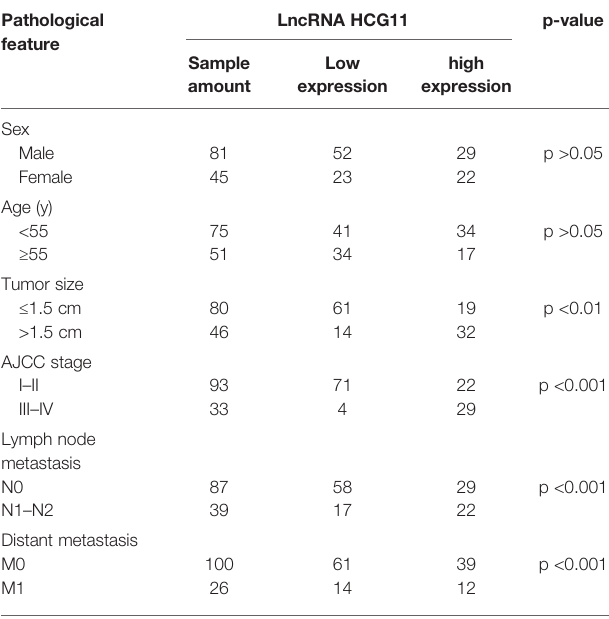
TABLE 1 | High and low HCG11 expression in nasopharyngeal carcinoma in the study population (n = 126) and strati fi ed according to demographic and clinical